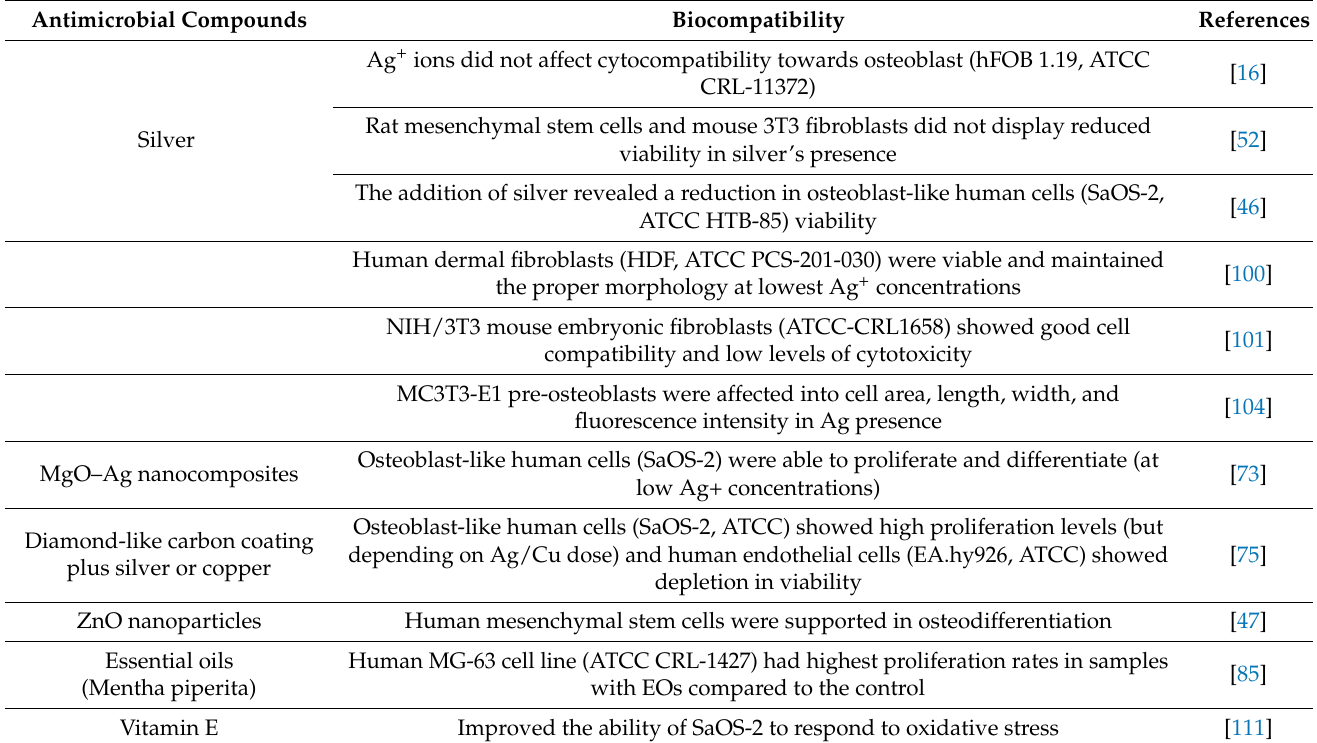
Table 3. Summary of antimicrobial and anti-adhesive compounds added to biomaterials used in orthopedic applications: data on their